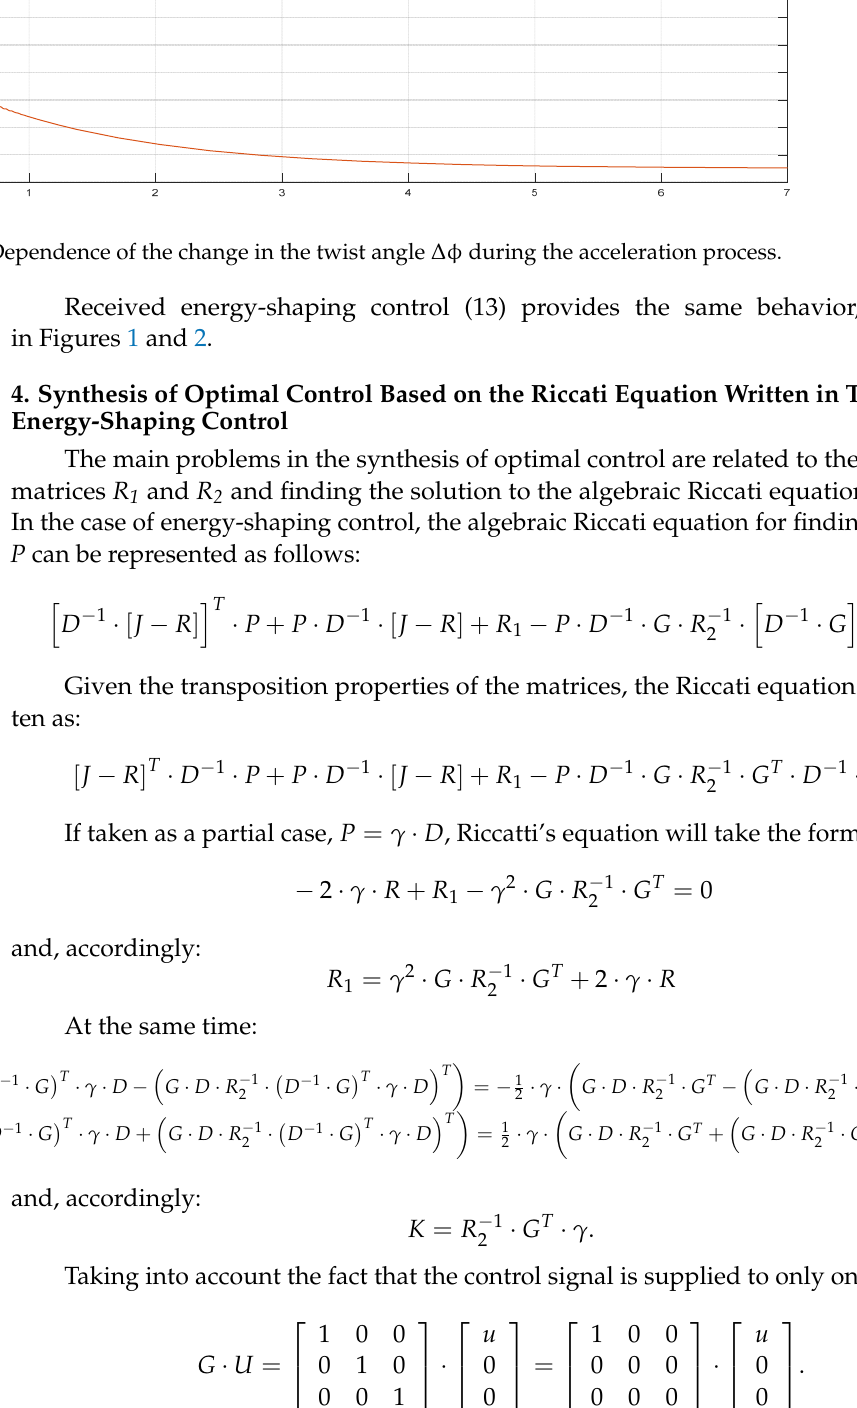
Figure 1. Dependences of change in speeds of the first (green) and second (purple) masses during acceleration: ( а ) accel- eration to the desired value; ( b ) the beginning of the acceleration process.